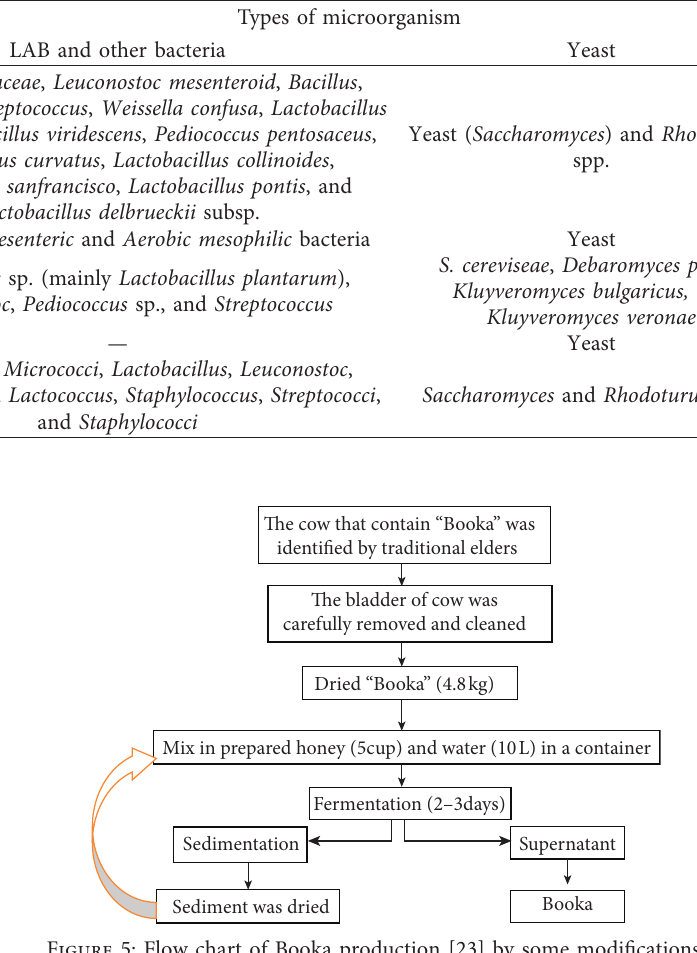
Table 3: The main microorganisms associated with some of traditional fermented beverages.